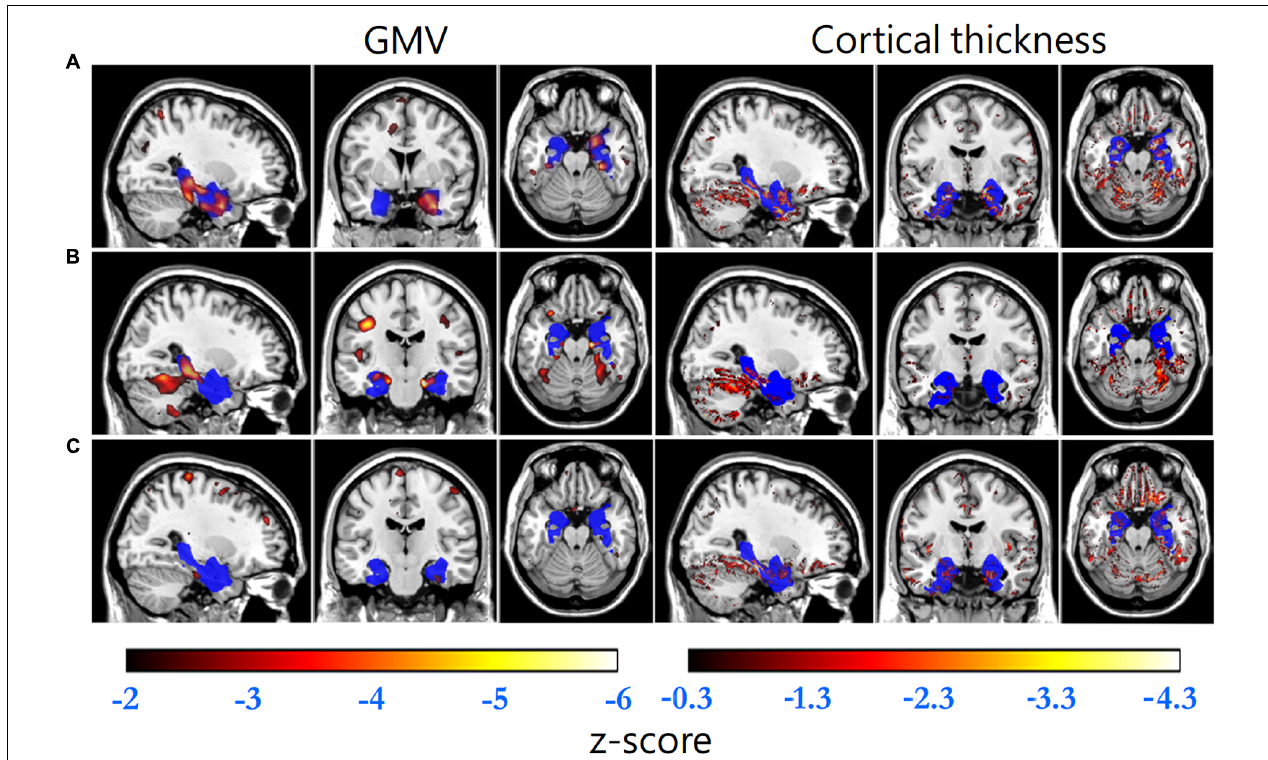
FIGURE 1 | Standard brain template overlaid by the VOI (blue) and the regions with GMV z -scores less than − 2 (hot, left column) and cortical thickness z -scores less than − 0.3 (hot, right column) of (A) an AD patient (GMV decline indicator: − 1.699, cortical thickness decline indicator: − 0.079), (B) a MCI patient ( − 1.122, − 0.011) and (C) a normal control ( − 0.502, − 0.013),